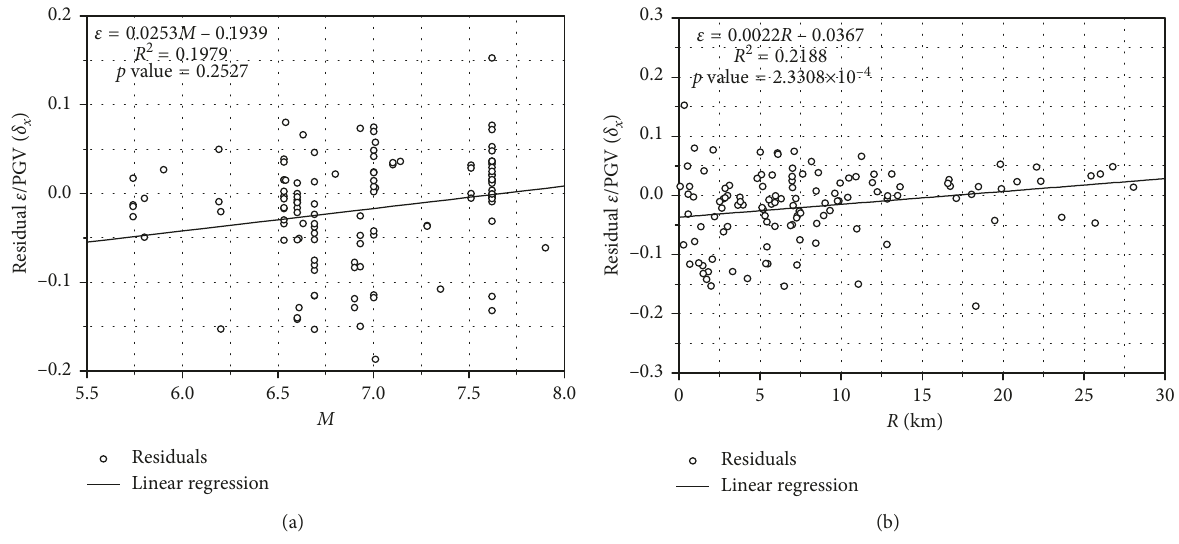
Figure 6: Sufficiency examination of PGV with conditional statistical dependence on (a) M and (b) R